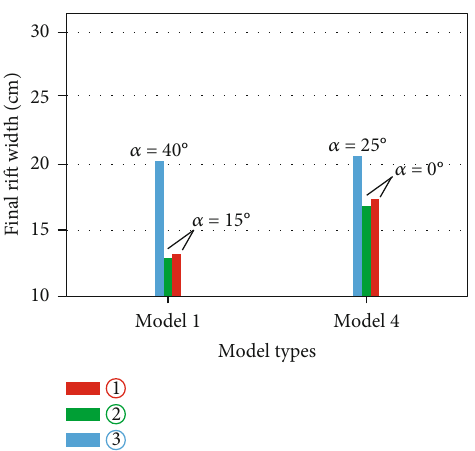
Figure 10: Relationship between di ff erent inclination angles and rifting